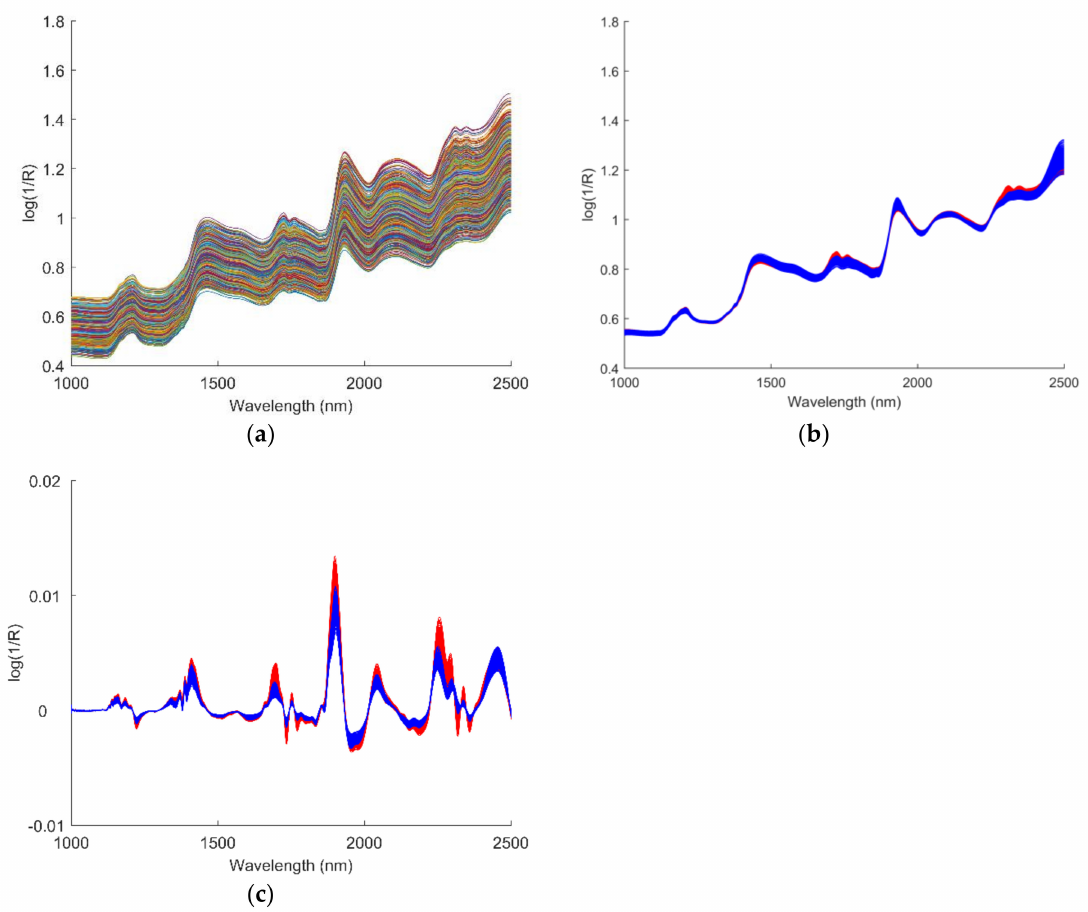
Figure 2. The spectra collected from two cultivars of sweet corn seed samples. ( a ) The full-range wavelengths from 1000 nm to 2500 nm, ( b ) the spectra pre-processed by MSC (cultivar H8 in red and H168 in blue), and ( c ) the spectra pre-processed by the Savitzky–Golay first derivative (cultivar H8 in red and H168 in blue).